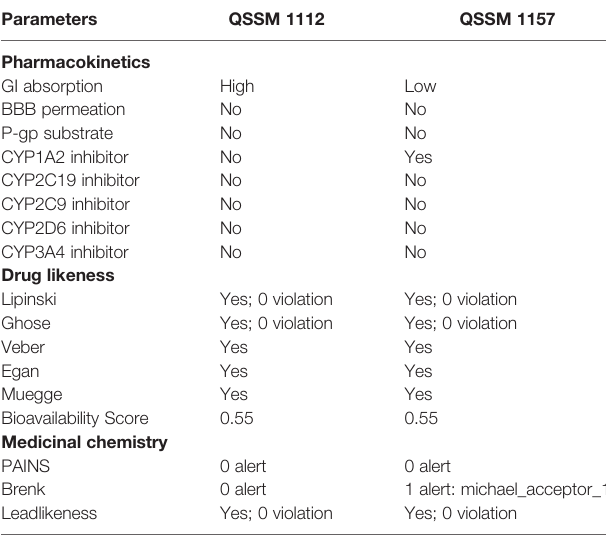
TABLE 3 | Pharmacokinetics, drug likeness, and medicinal chemistry properties of QSSM 1157 and QSSM 1112 as predicted through SwissADME.